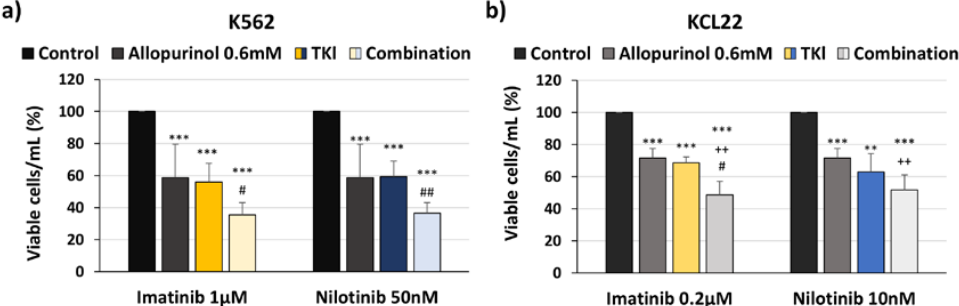
Figure 4. Allopurinol and tyrosine kinase inhibitor (TKI) combination reduces cell number more strongly than single agents. K562 and KCL22 cells were treated with TKIs (imatinib or nilotinib), allopurinol, or their combinations for 48 h. The number of viable cells was counted by trypan blue exclusion. ( a ) Number of viable K562 cells with respect to control ( n = 5). ( b ) Number of viable KCL22 cells with respect to control ( n = 5). Significant di ff erences: *** p < 0.001, ** p < 0.01 with respect to control; ++ p < 0.01 with respect to allopurinol-treated cells; ## p < 0.01, # p < 0.05 with respect to TKI-treated